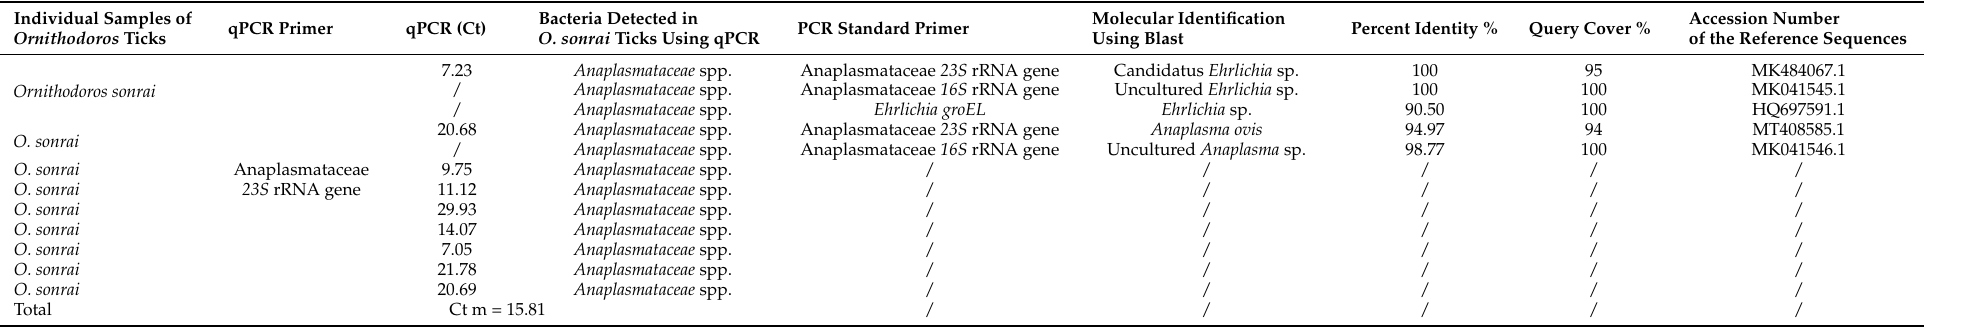
Table 2. Results of qPCR, standard PCR and BLAST from O. sonrai tested by targeting primers Anaplasma spp. 23S rRNA, Anaplasmataceae 16S rRNA and Ehrlichia groEL